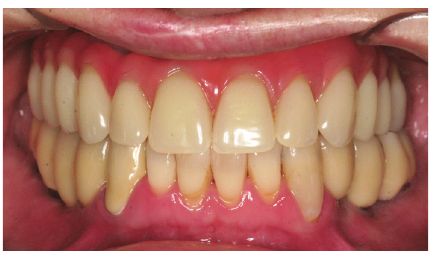
Figure 7: Frontal view of final